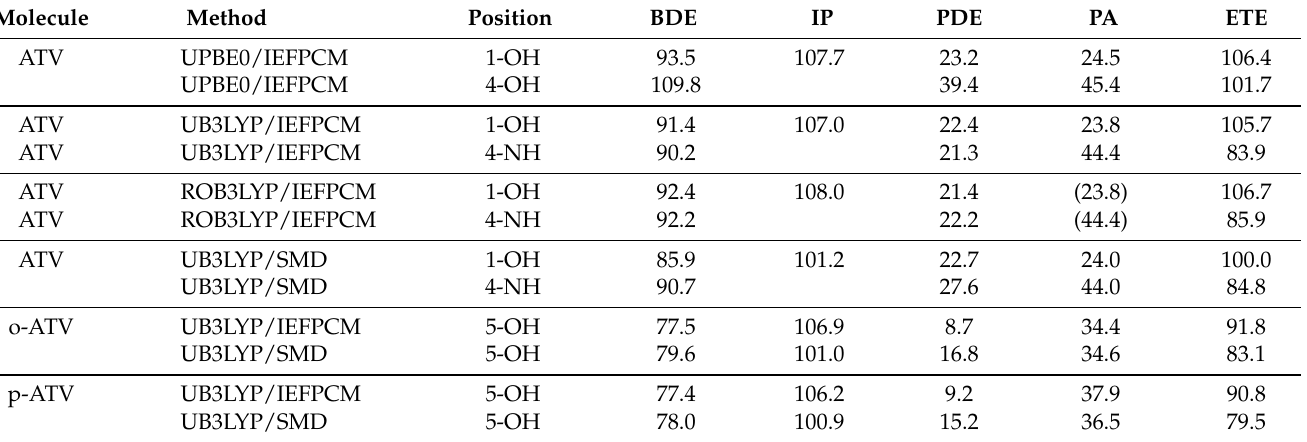
Table 5. Enthalpies of reaction (in kcal/mol) computed for atorvastatin (ATV) using methods indicated above and 6-31+G(d,p) basis sets. There is no difference between unrestricted (UB3LYP) and restricted open shell (ROB3LYP) methods in calculating the PA values, and for this reason the pertaining value was written in